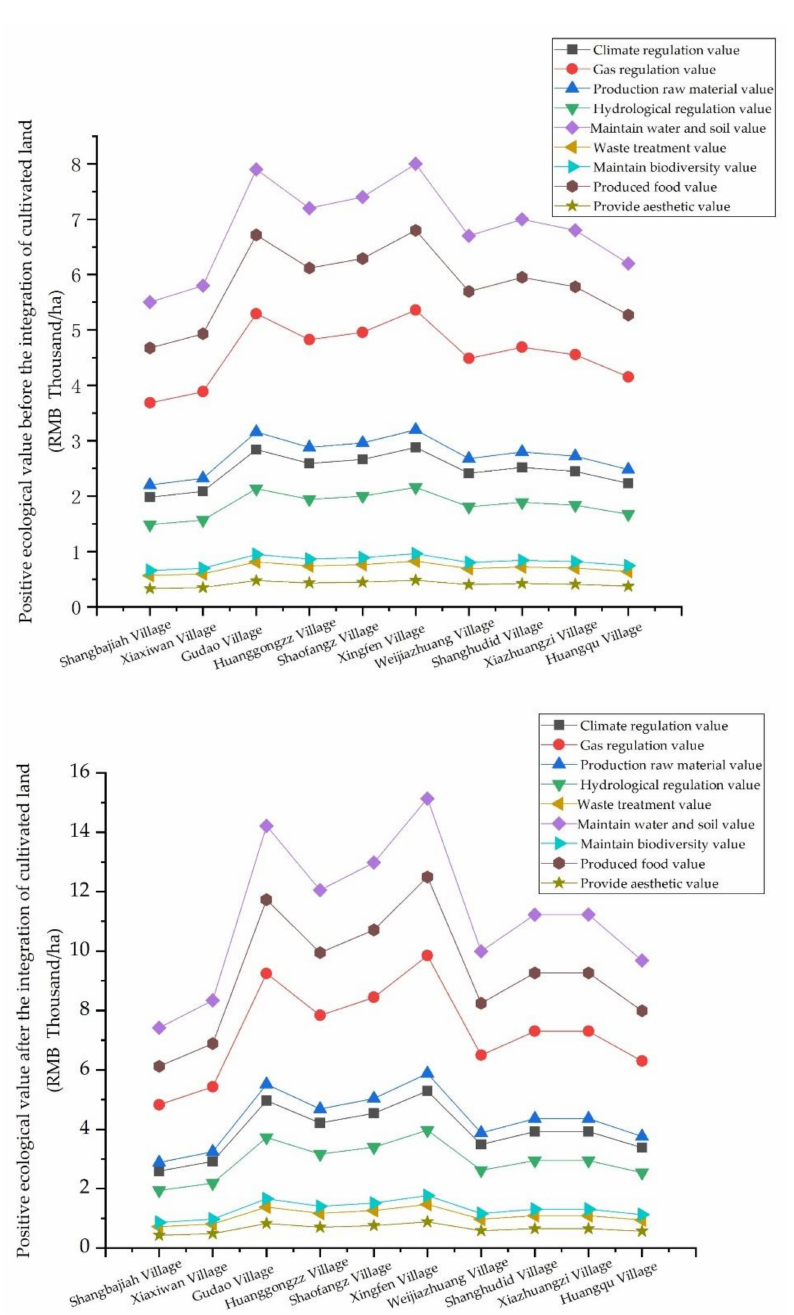
Figure 5. The positive pro-ecological value of cultivated land before and after